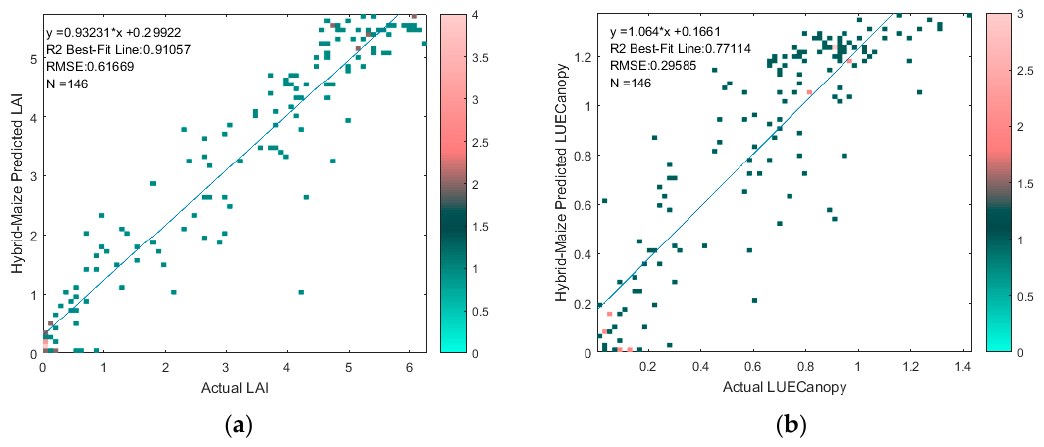
Figure 1. Comparison of actual versus Hybrid-Maize modeled ( a ) LAI and ( b ) LUE Canopy . The color bars represent the number of points at each marker on the scatter plot.